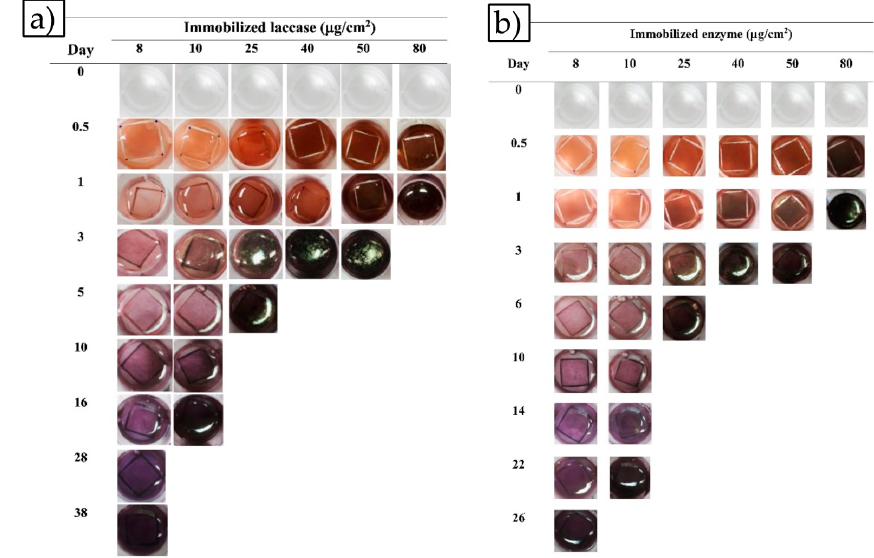
Figure 13. Color change of ( a ) ceCPL (8–80 µ g / cm 2 ) stored in a 4 ◦ C showcase refrigerator and ( b ) ceZL (8–80 µ g / cm 2 ) reacted with guaiacol at 4 ◦ C. ( a ) Reproduced with permission from [143],